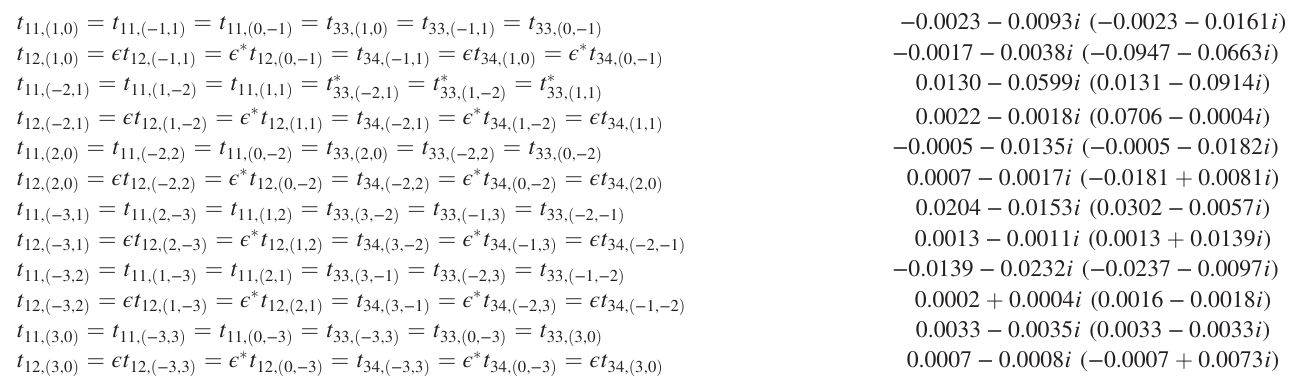
TABLE II. The hopping constants among w 1 themselves and w 3 themselves. The number outside (inside) the parentheses is for ; 2 ; 4 WSs obtained from the projection method ( WANNIER 90 ). All the numbers are in units of milli-electron volts. ¼ t ¼ t ¼ t ¼ t ¼ t t 11 11 ; ð − 1 ; 1 Þ 11 ; ð 0 ; − 1 Þ 33 ; ð 1 ; 0 Þ 33 ; ð − 1 ; 1 Þ 33 ; ð 0 ; − 1 Þ ; ð 1 ; 0 Þ